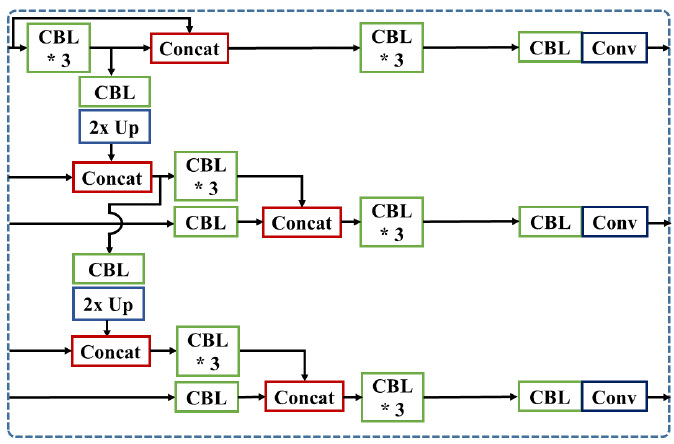
Figure 10. Detailed architecture of SLCat. (’ ∗ ’ means the repetition of CBL).